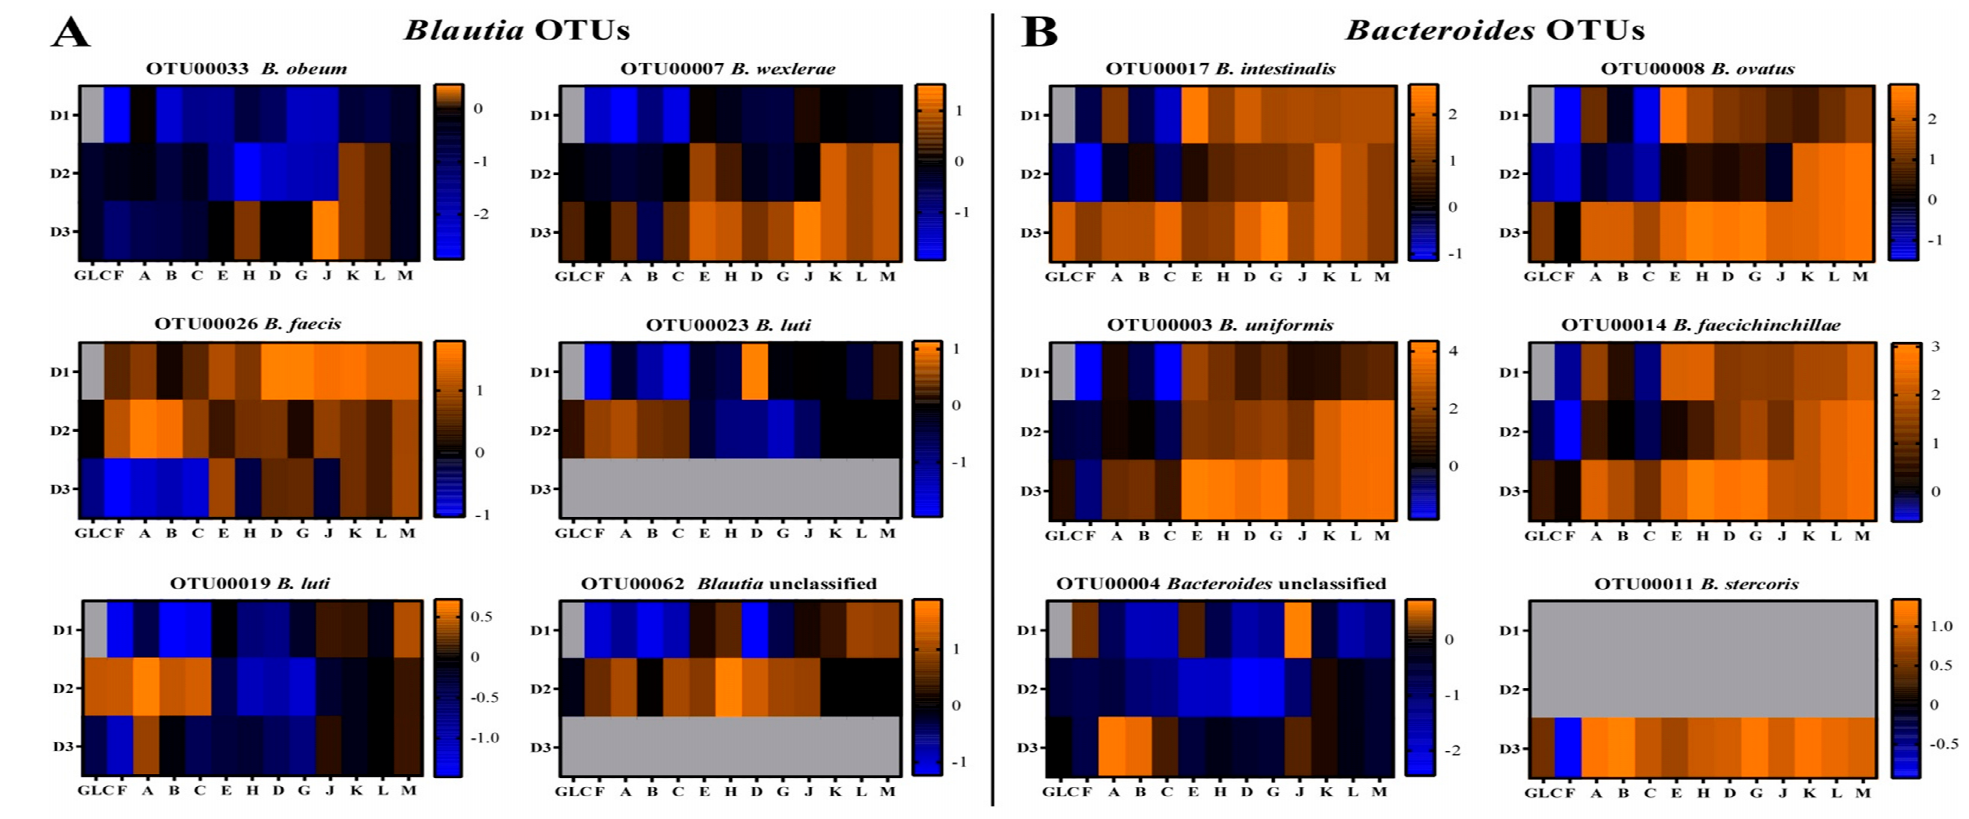
Figure 9. Log 2 -transformed fold change of OTU relative abundances within genera Blautia ( A ) and Bacteroides ( B ) after glucan fermentation across three donor communities. Orange shades represent increases in abundance; blue shades represent decreases in abundance; black indicates no change in abundance with respect to the initial microbiota. OTUs not detected within an individual’s inoculum are gray.